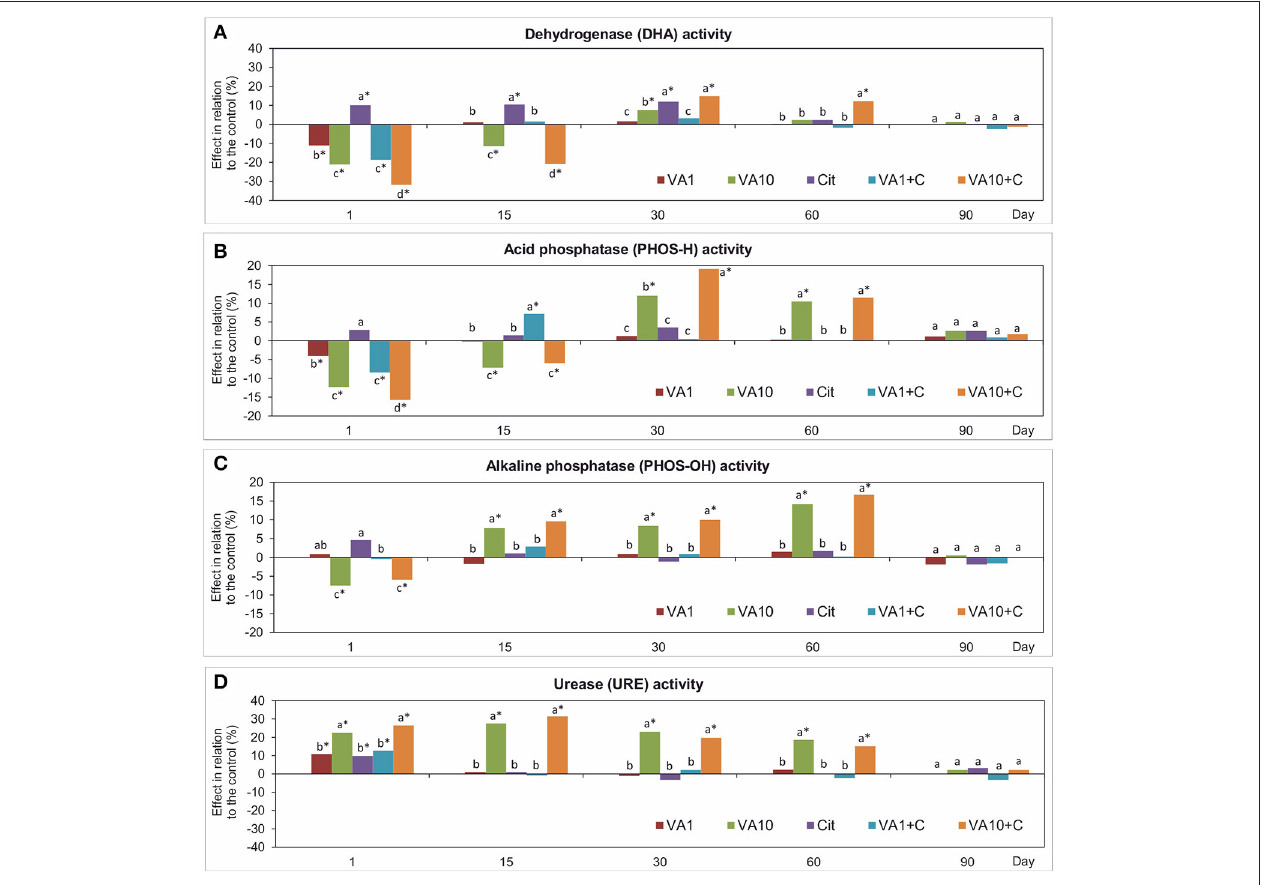
FIGURE 5 | Effect of VA and/or C . freundii on the DHA (A) , PHOS-H (B) , PHOS-OH (C) , and URE (D) activity during the experimental period. The data are the means ( n = 3) and expressed as a percentage of the inhibition or stimulation in relation to the control soil. Different letters and asterisks within the values of each enzyme indicate significant differences between treatments, and between treatments and control at the same sampling time (LSD post hoc test; P < 0.05), respectively. The explanation of the treatment abbreviations is given in Figure 1